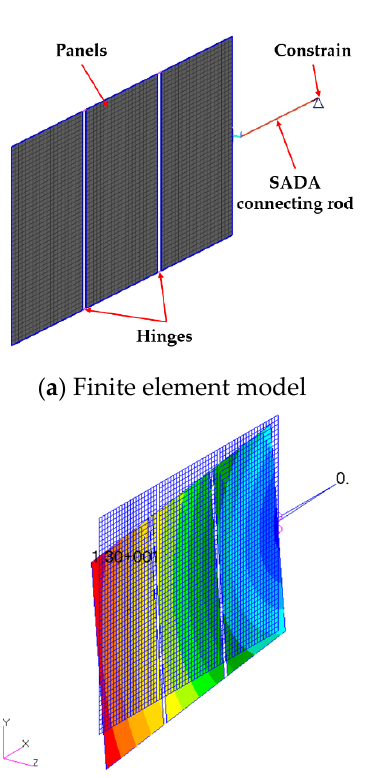
Figure 4. Solar array of a satellite.